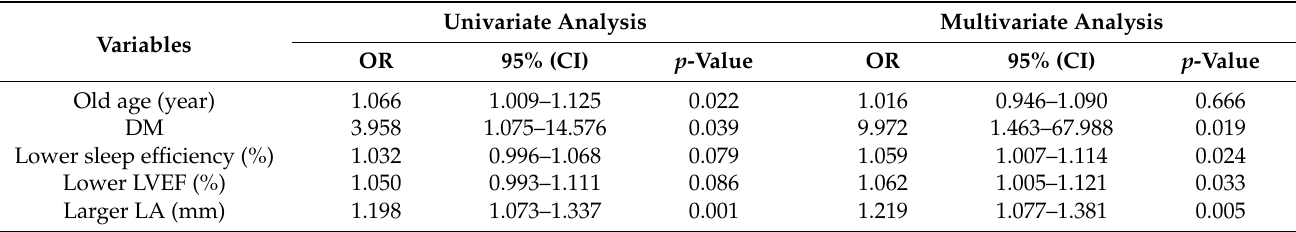
Table 2. Univariate and multivariate analysis for predictors of atrial fibrillation in patients with obstructive sleep apnea